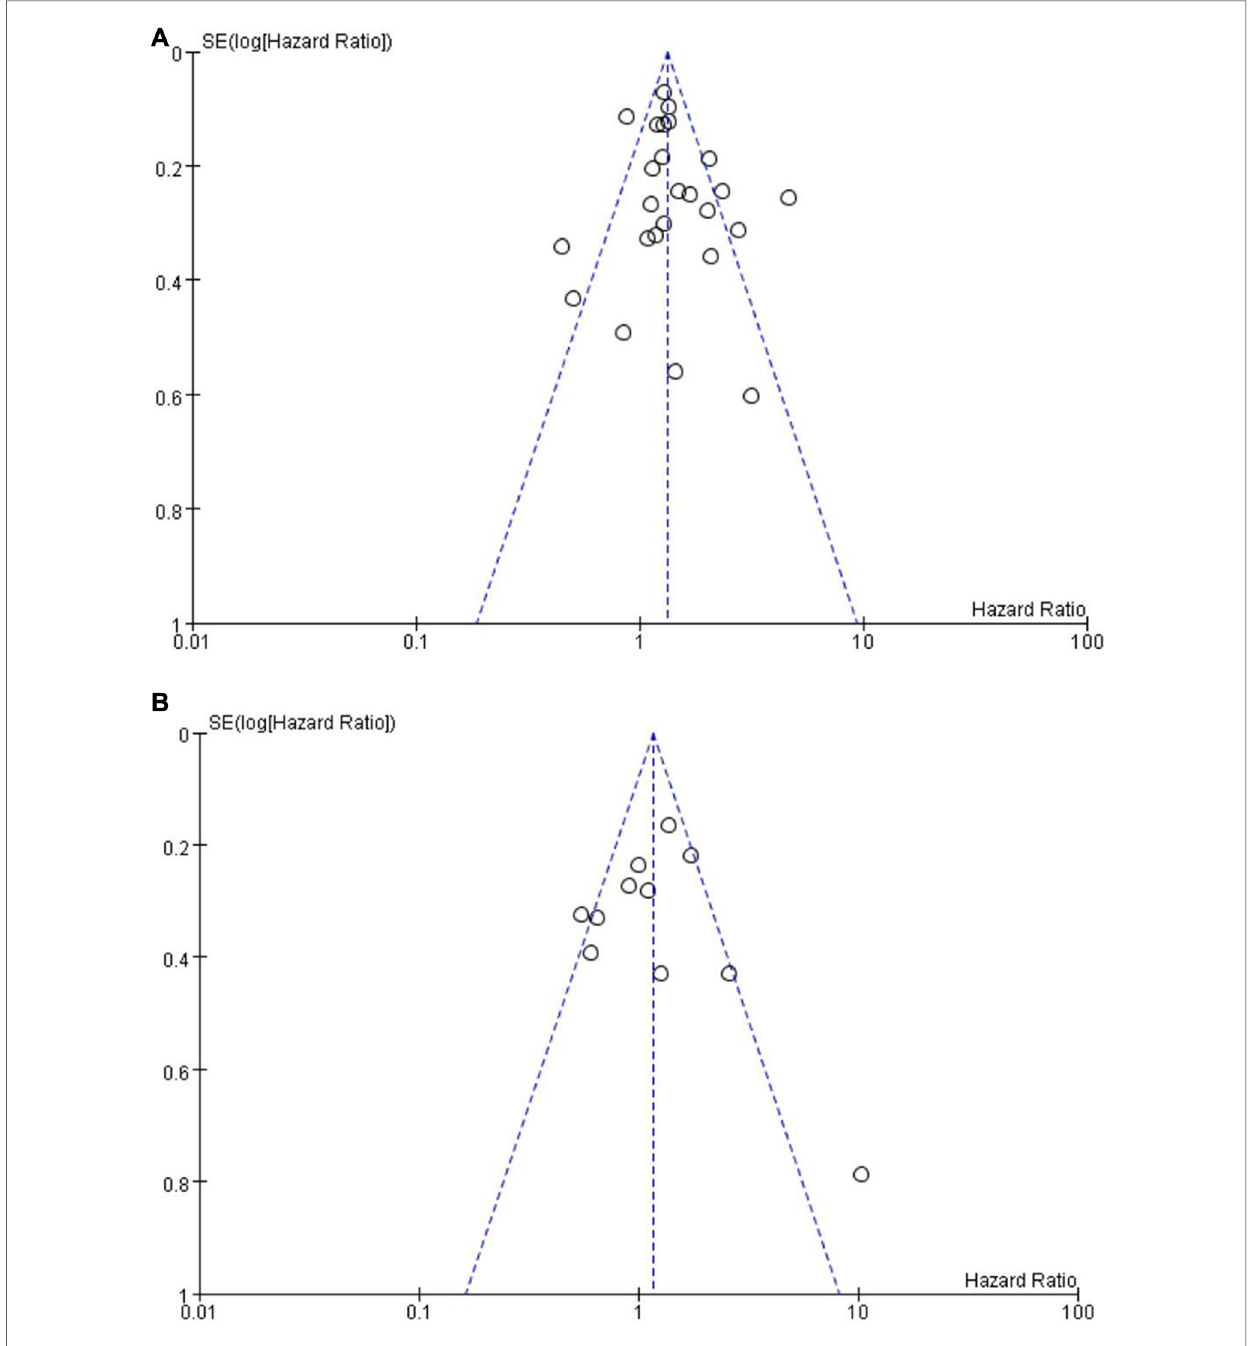
FIGURE 7 Funnel plot on the association of overall survival ( A ) and progression-free survival ( B ) with different levels of platelet-to-lymphocyte ratio